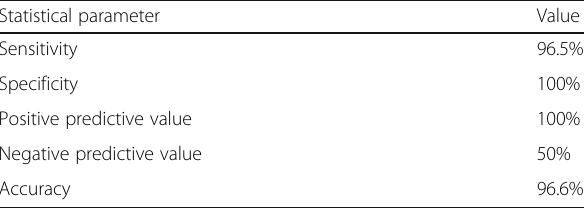
Table 5 Accuracy measures for tumoural residual\recurrence as detected by 68Ga-labelled PSMA-ligand PET/CT Statistical parameter Value Sensitivity 96.5% Specificity 100% Positive predictive